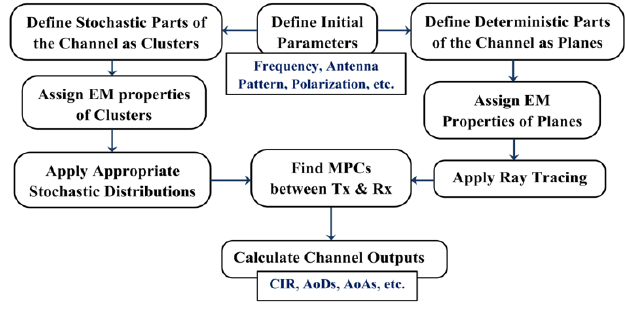
Figure 4. The flowchart of proposed channel